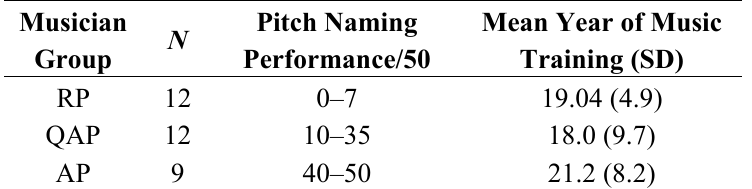
Table 1. The musical skill and training of the musician groups. RP, relative pitch; QAP, quasi-absolute pitch; AP, absolute